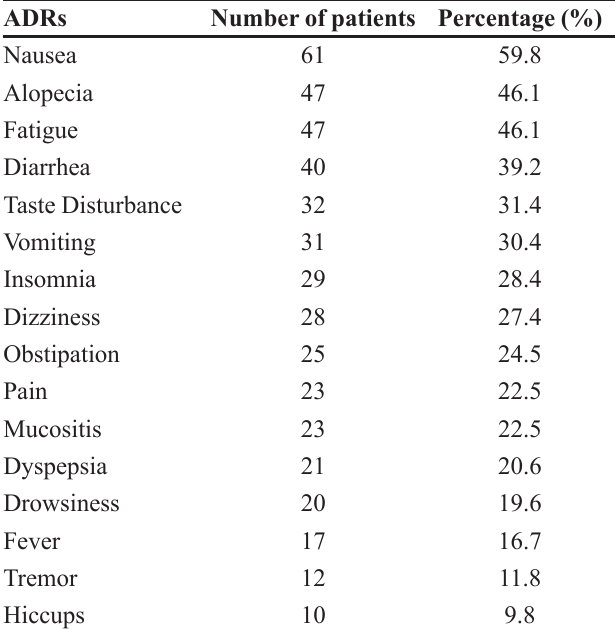
TABLE IV - Incidence of adverse drug reactions (ADRs) reported by outpatients on antineoplastic treatment at the Chemotherapy Clinic from October to November 2010